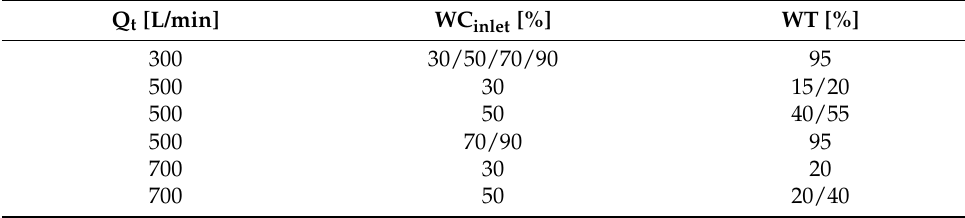
Table 3. Spiked Exxsol D60 Experimental campaign infill test